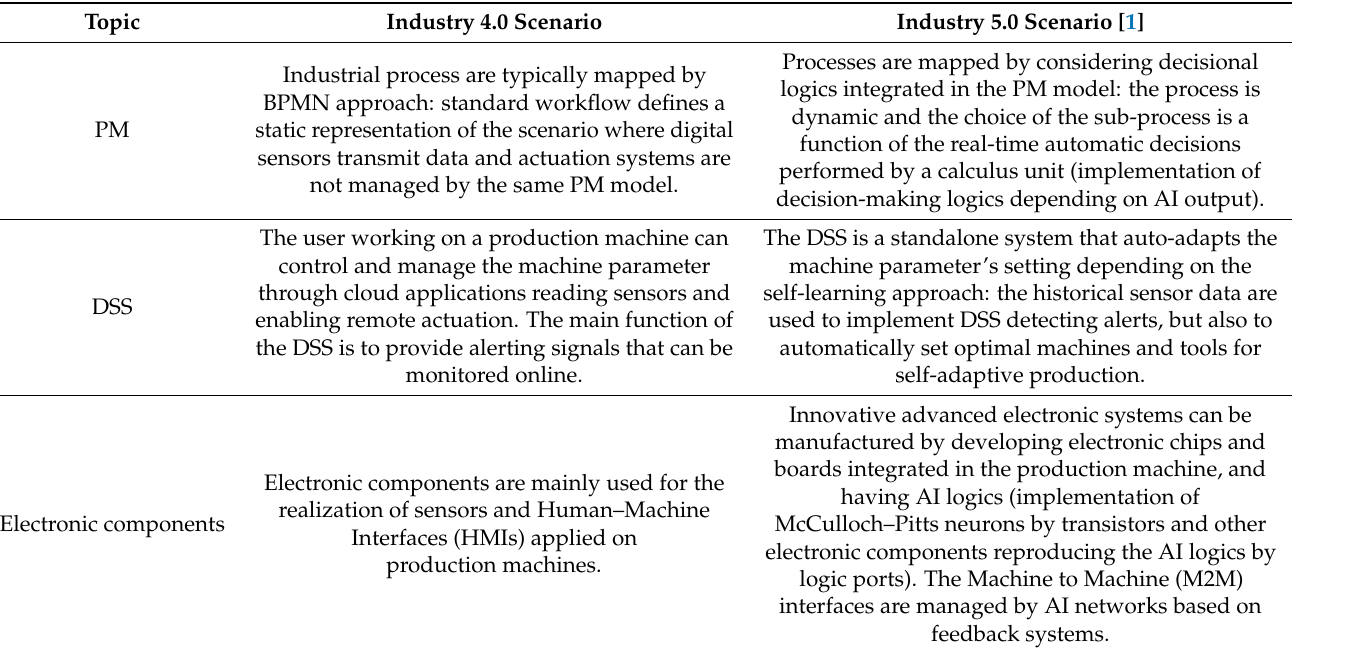
Table 1. Main topics of the paper and relations to Industry 4.0 and Industry 5.0